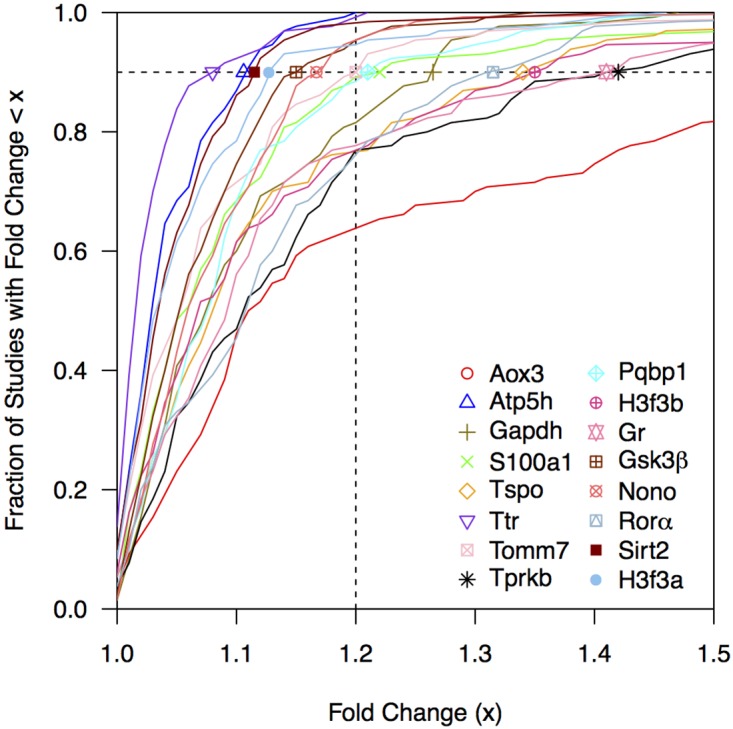
Fold-changes observed in 130 mouse liver transcriptome experiments.For each gene, we calculated and plotted the cumulative distribution of the fold-changes observed in a large set of 130 transcriptome experiments using mouse liver tissue. We considered candidate genes to pass this assessment if their fold-change was < 1.2 in 90% of all studies (indicated by dashed lines).